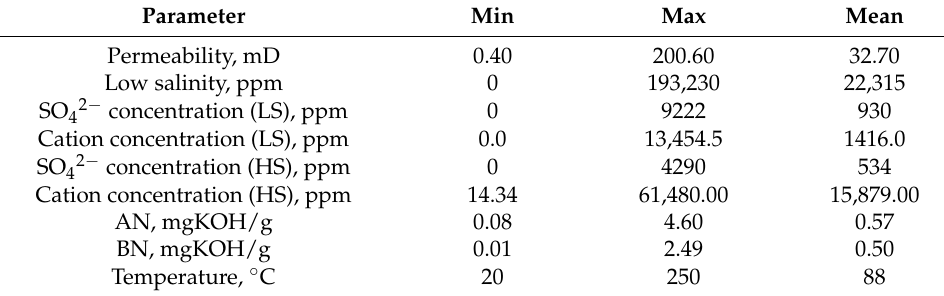
Table 2. Statistical measures of the